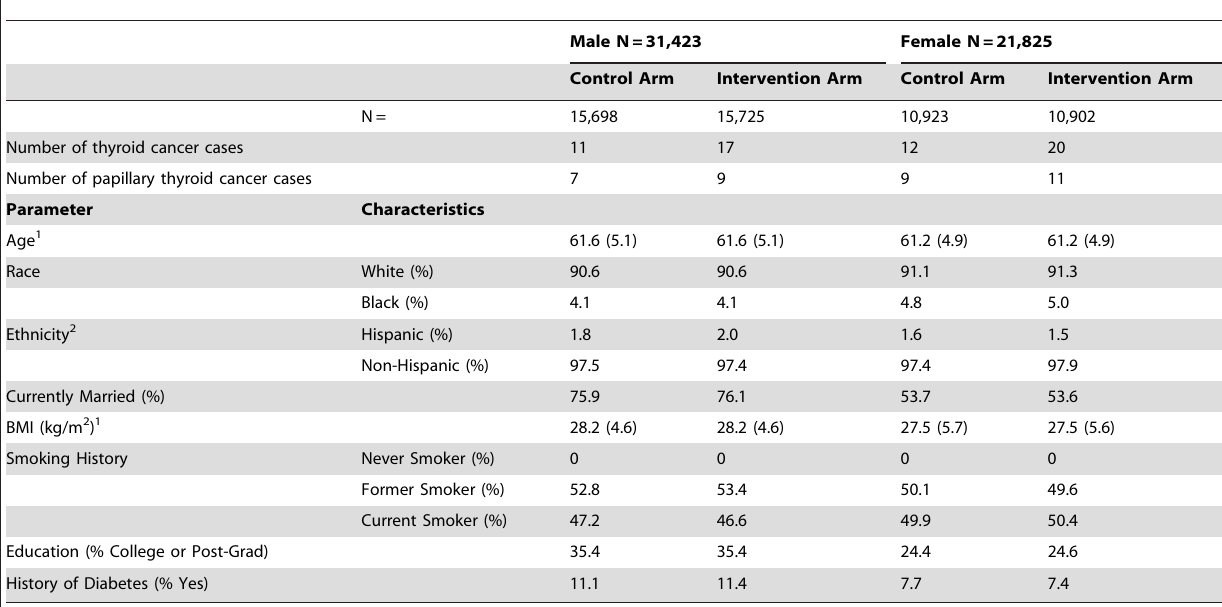
Table 1. Baseline characteristics of participants in NLST by randomization